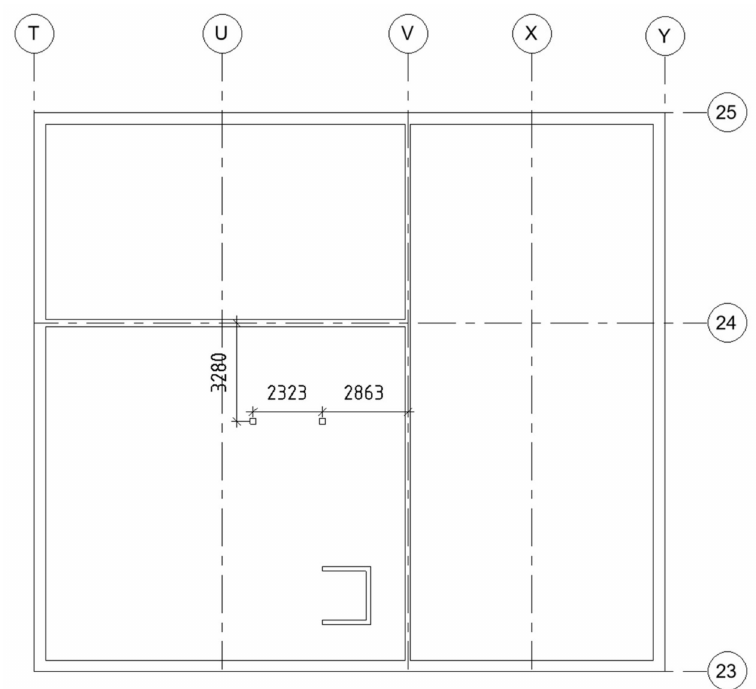
Figure 4. Plan of story 2 (unit: